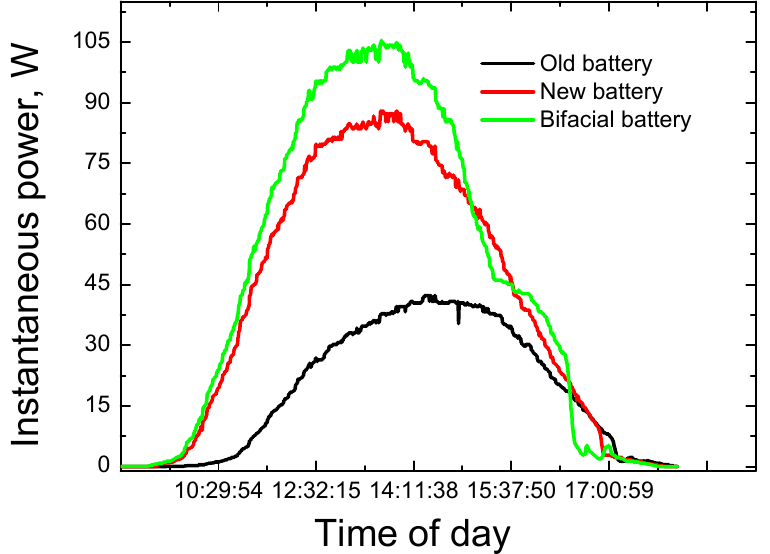
Figure 7. Instantaneous dependence of solar power on time of the day.